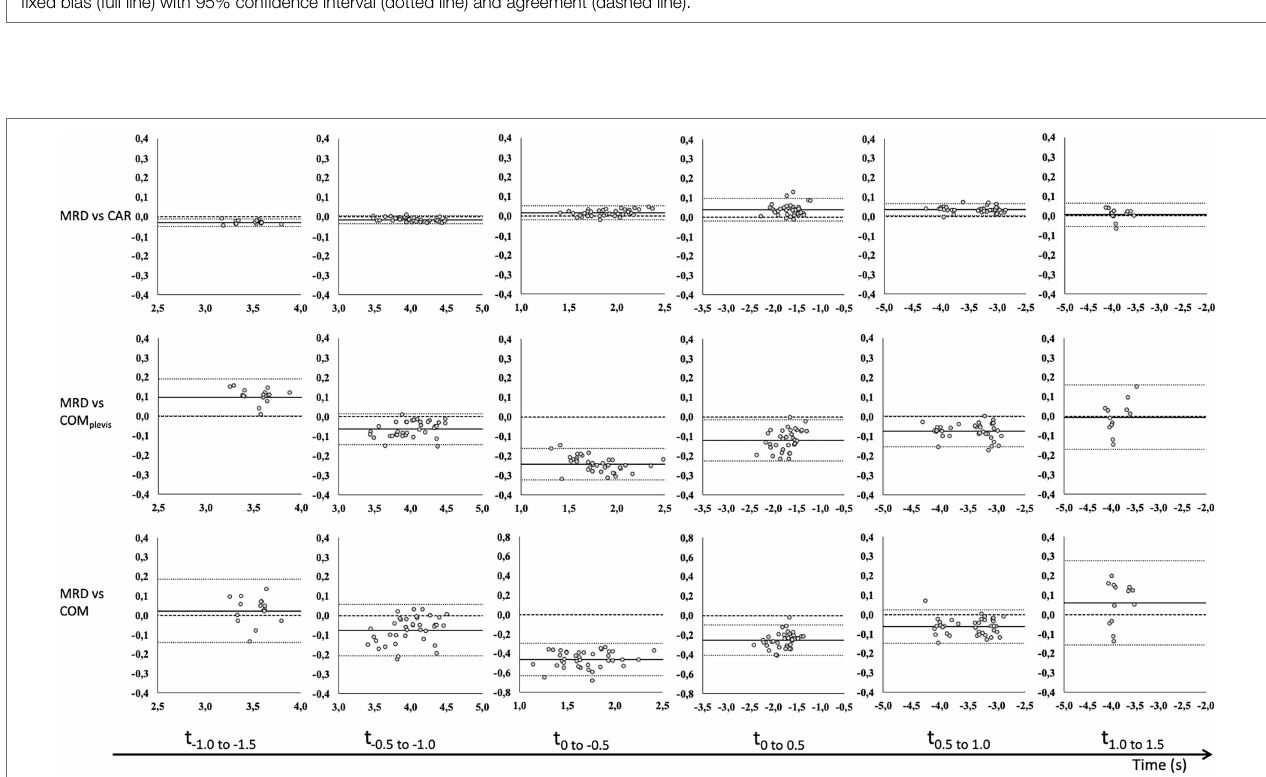
FIGURE 2 | Bland–Altman analysis of average velocity for 0.5 s time intervals before ( − ) and after (+) CoD (horizontal axis) for the MRD to CAR (top row), COM pelvis (middle row), and COM (bottom row) for 3 kg external load. Bland–Altman plots [y-axis: difference in velocity (m/s) and x-axis: average velocity (m/s)] for all trials with fixed bias (full line) with 95% confidence interval (dotted line) and agreement (dashed line).